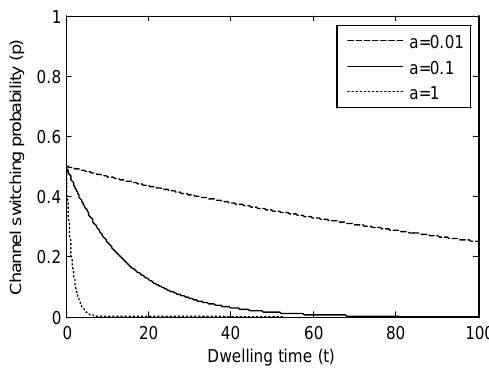
. Figure 5. Channel switch probability under different α .